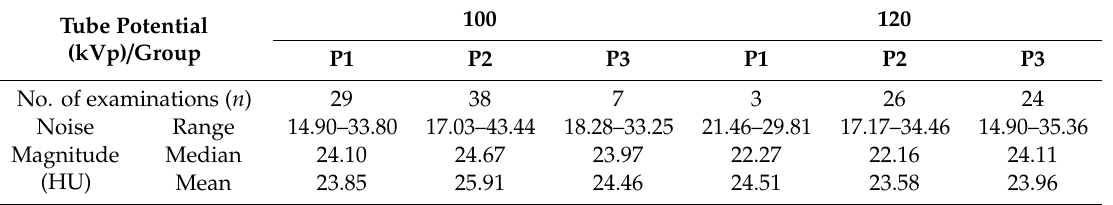
Table 4. Noise magnitude measurements according to the AP body length groups.